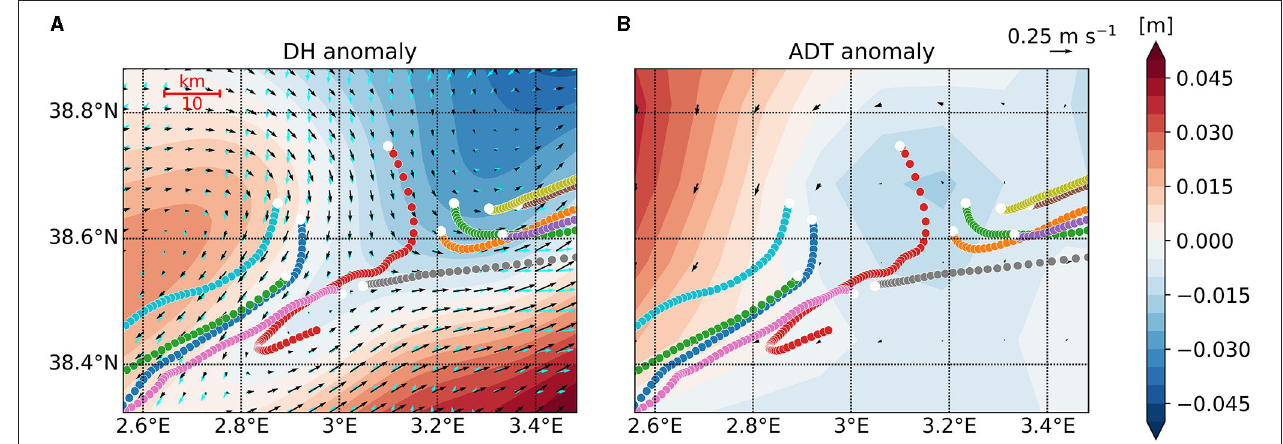
FIGURE 5 | (A) Dynamic height (DH) anomaly at 5 m depth and geostrophic velocity vectors (in black) at 20 m depth (for consistency with ADCP velocity) calculated using CTD data from Leg 1. ADCP velocity vectors at 20 m depth are plotted in cyan. For clarity, only one out of two current vectors are plotted. (B) Absolute dynamic topography (ADT) anomaly computed from CMEMS altimetry gridded products on 3 May 2018 and derived geostrophic velocity vectors. All velocity vectors are plotted with the same scale. Dots show the trajectories followed by the drifters released during the PRE-SWOT experiment for the period 5–13 May; white dots are the release positions, and the time period between each drifter location is 2h.